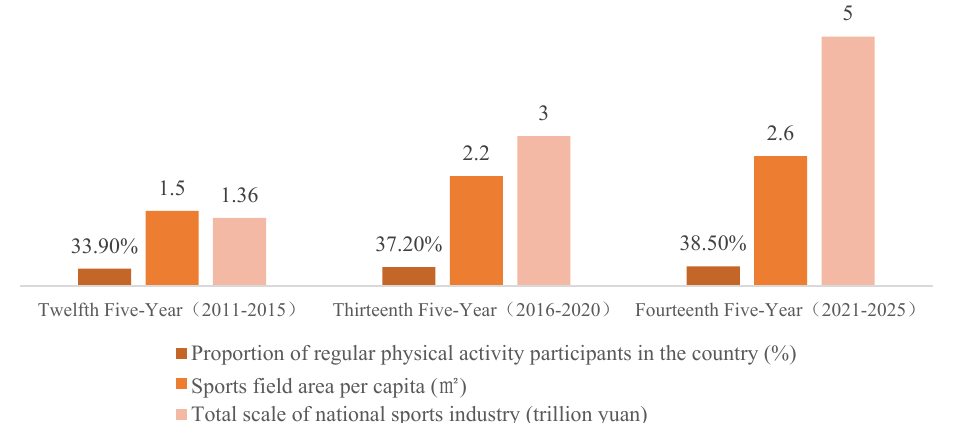
Figure 1. Summary of the development of national fitness and trends in China.